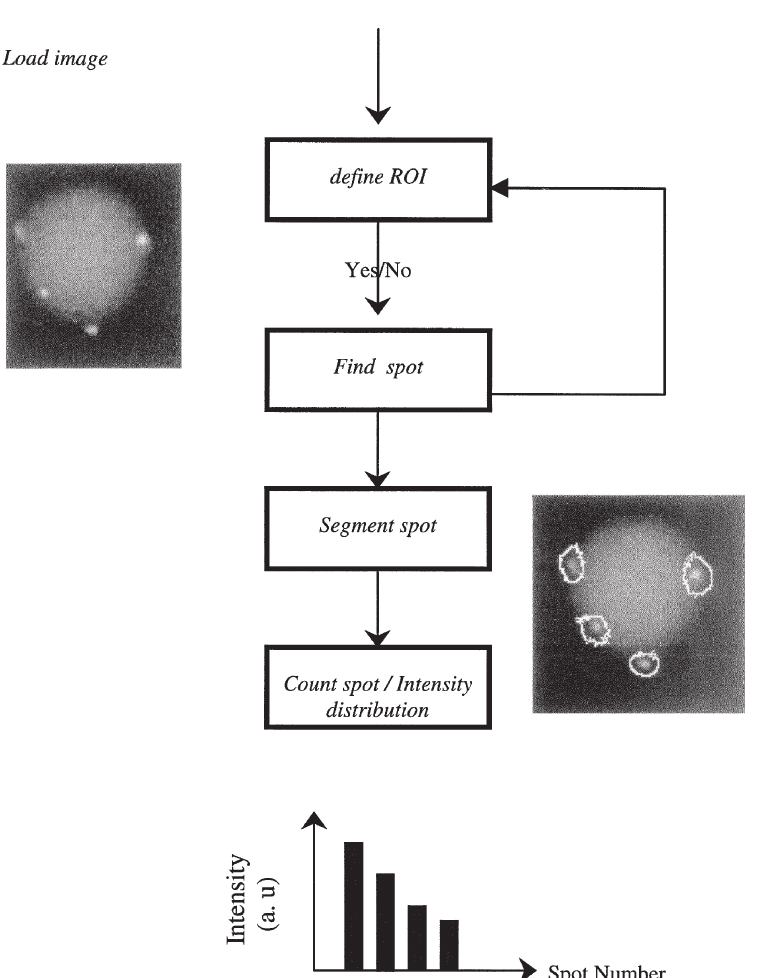
Fig. 1. Schematic description of the spot finding algorithm. The digitized raw image (left) was subjected to several analysis steps. The results are an image with segmented labelling sites (right) from which quantative values of intensity or area, for instance, can be